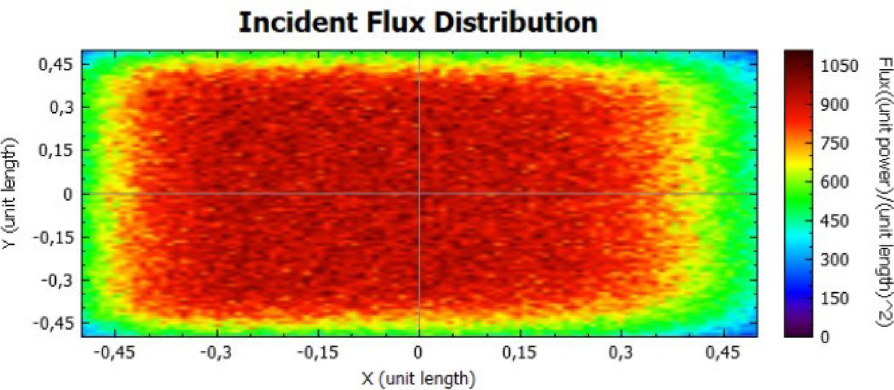
Figure 16. Incident Flux Distribution for an optical error of 0.030 (Flat Concentrator; 92% of